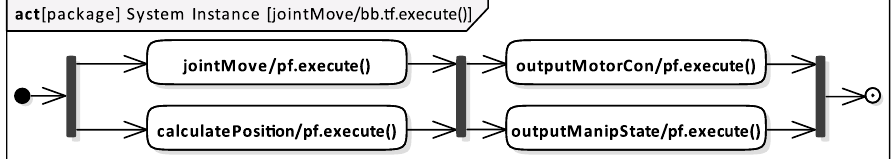
Figure 15. jointMove / bb . tf . execute () operation definition.